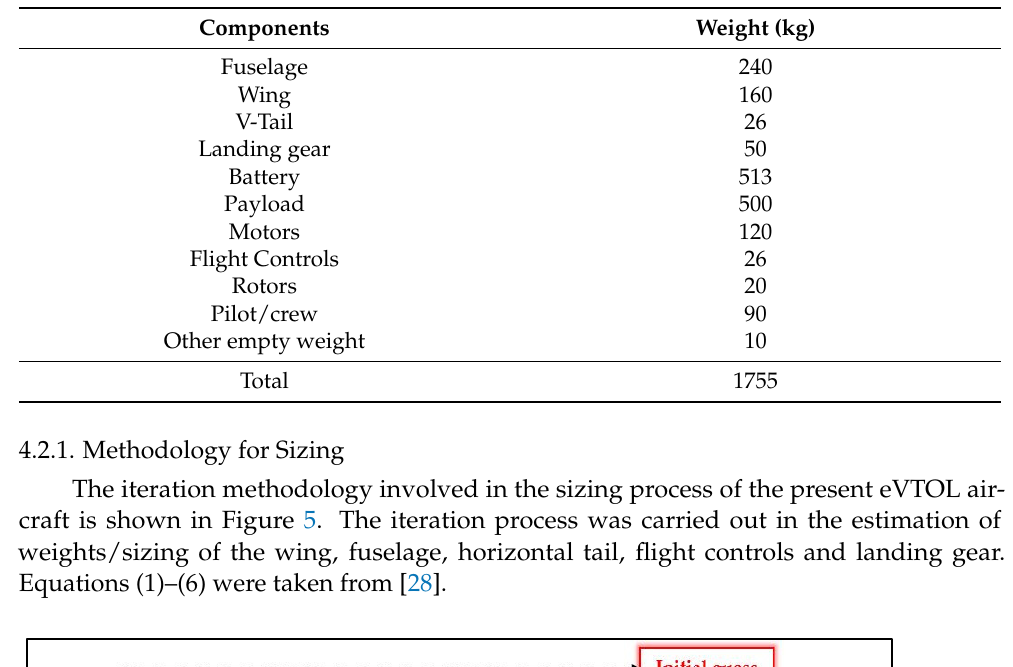
Table 3. Weight split up.